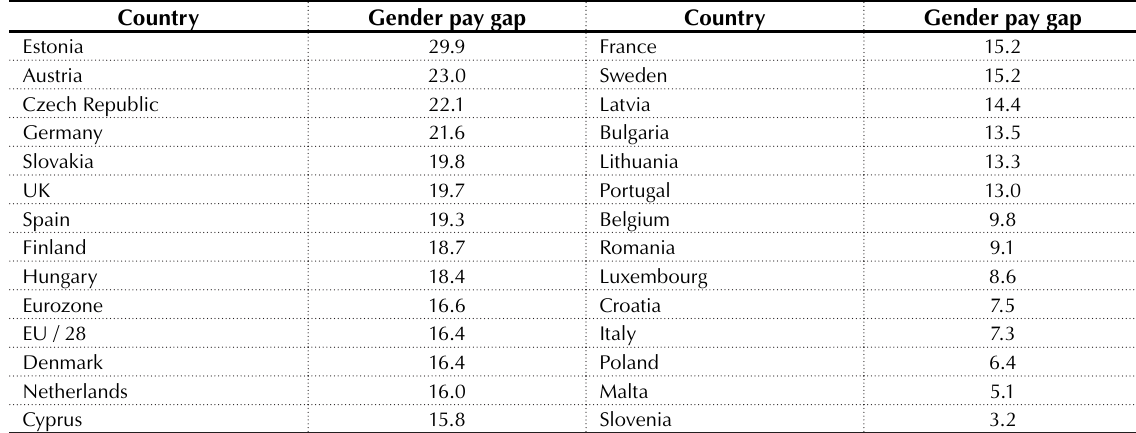
Source: elaborated by authors according to Európskakomisia